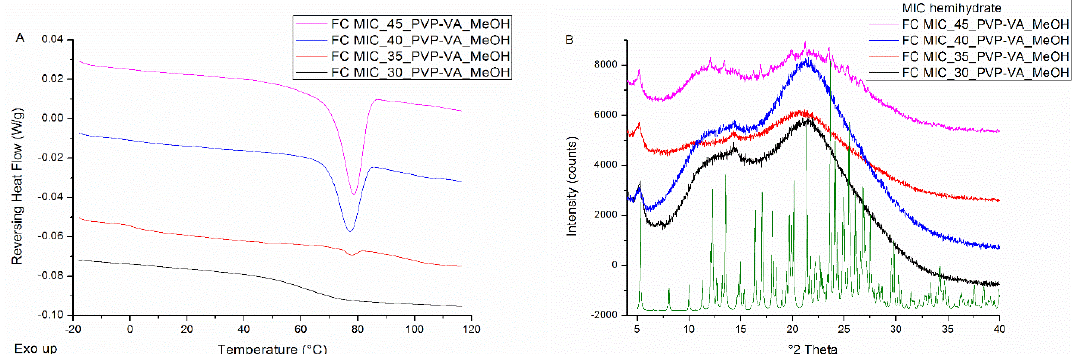
Figure 2. ( A ) mDSC thermograms of film casted (FC) MIC-poly(vinylpyrrolidone-co-vinyl acetate) (PVP-VA) systems, increasing the drug loading from 30% (black) to 45% (pink) by intermediate steps of 5%. The RHF signals are shown as arbitrary units; ( B ) corresponding X-ray powder diffraction (XRPD) diffractograms and the diffractogram of MIC hemihydrate (green) as comparison. The intensities are shown as arbitrary units. The small observable peaks just before 15° are due to the Kapton ® Polyimide Thin-films since XRPD measurements were conducted in transmission mode. Table 1. Average T g values and widths ± standard deviation (sd) for MIC_PVP-VA_MeOH films. Average T m,onset values and melting enthalpies ± sd are reported as well.